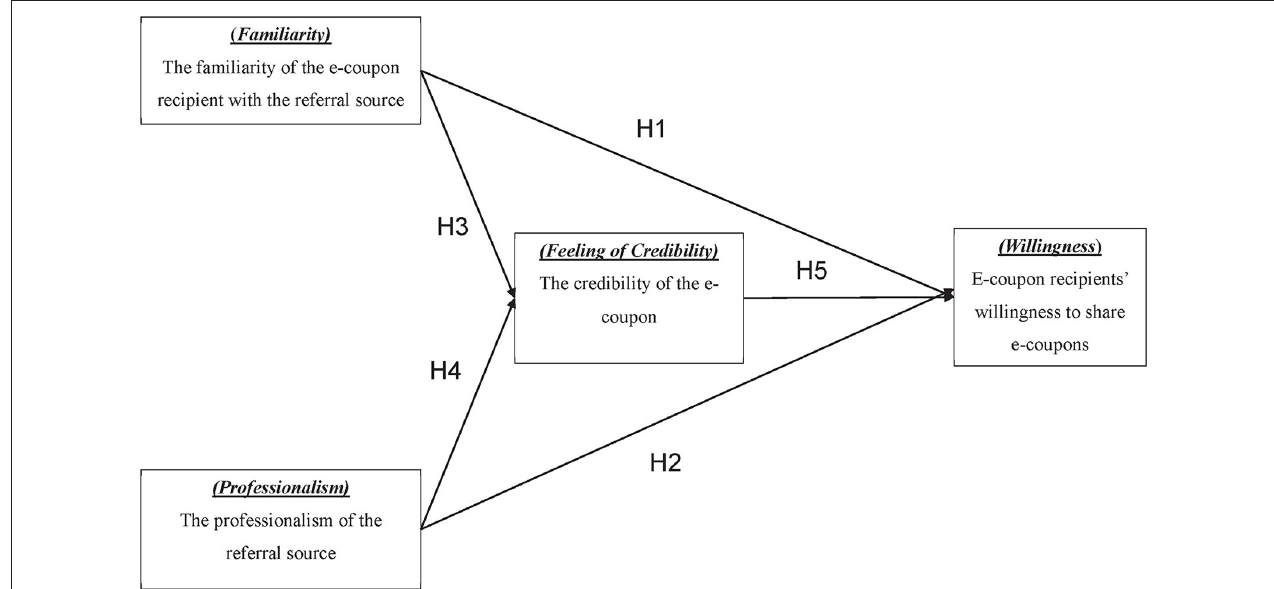
FIGURE 1 | Research framework of this